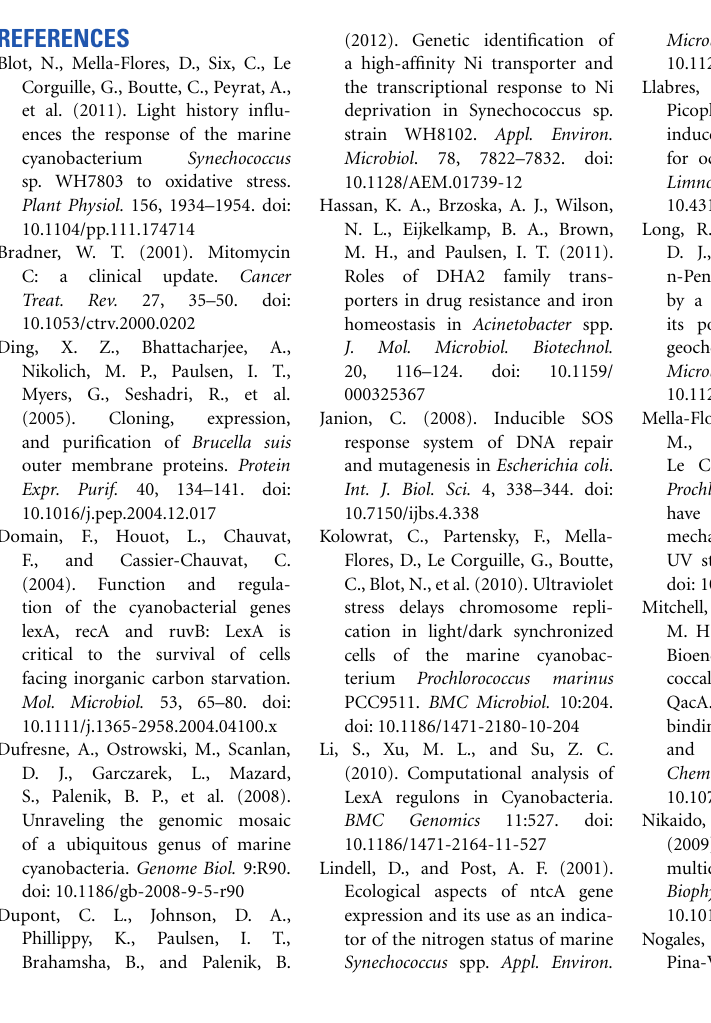
Table S1 | Complete list of Synechococcus sp. WH8102 and CC9311 genes whose expression was significantly affected by test conditions, according to SAM analysis. Genes are ordered according to log 2 fold change (shown in numerator column) with those showing the greatest change in expression under test conditions listed